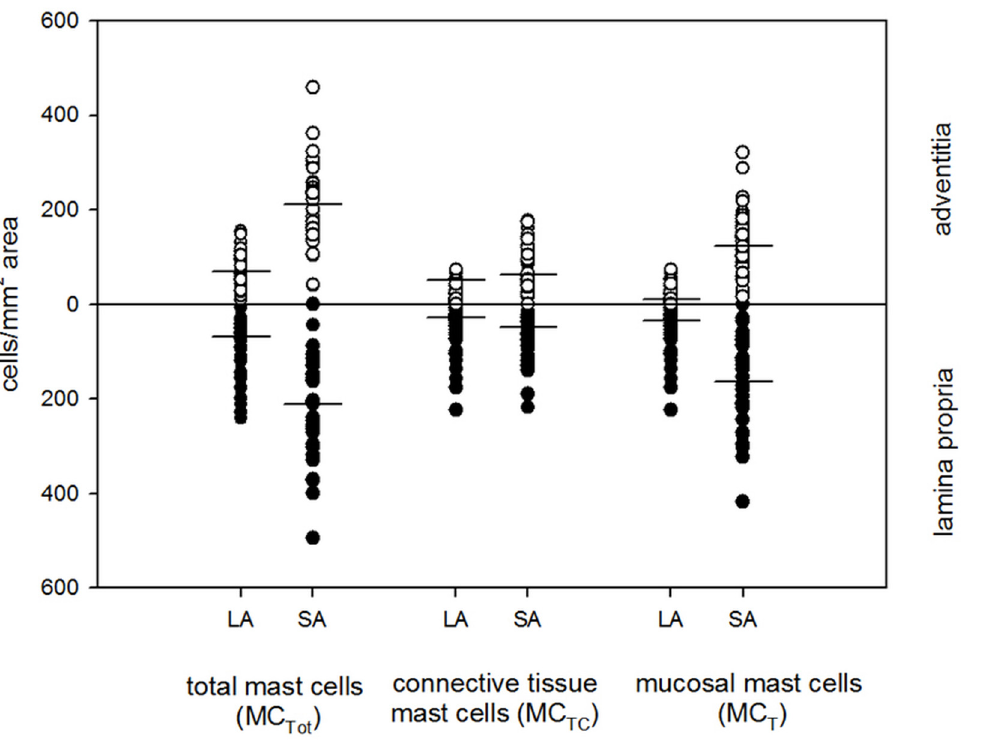
Fig 2. Cellular distribution of mast cells and their subpopulations. Median cellular distribution of mast cells and their subpopulations in the lamina propria and adventitia of large (LA) and small airways (SA) is presented. * P < 0.05. The difference between LA and SA in the lamina propria for MC T was 5-fold and 11-fold for the